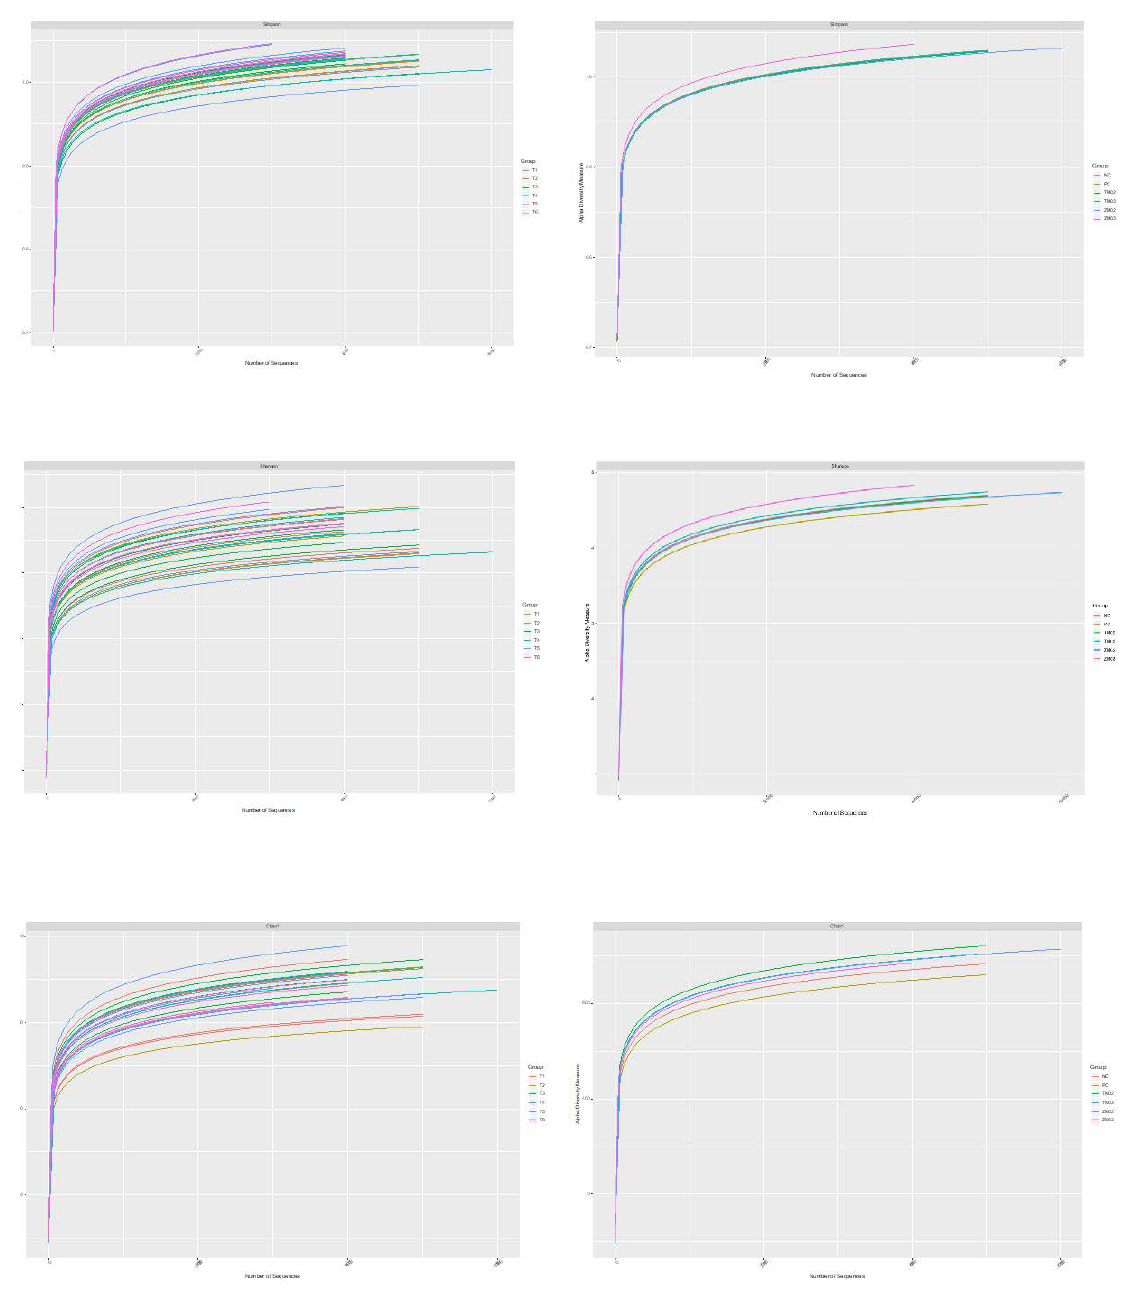
Figure 1. Rarefaction curves of alpha diversity cecum digesta, legends refer to sample: PC—positive control (salinomycin, 60 ppm); NC—negative control (no additives); TM02—(0.2% T. molitor full-fat meal); ZM02—(0.2% Z. morio full-fat meal); TM03—(0.3% T. molitor full-fat meal); ZM03—(0.3% Z. morio full-fat meal) .